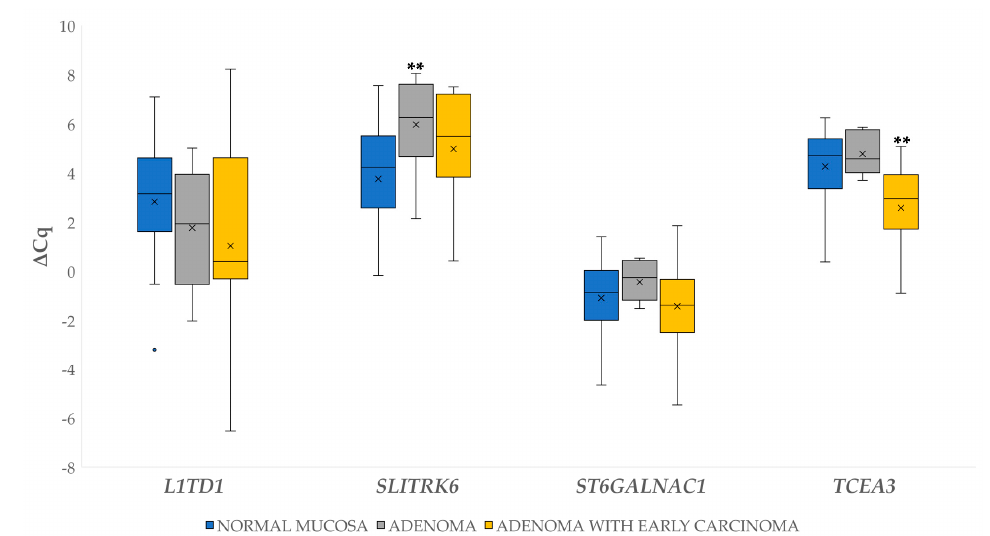
Figure 2. Expression ( ∆ Cq) of four genes ( L1TD1, SLITRK6, ST6GALNAC1, TCEA3) in normal mucosa, adenoma and adenoma with early carcinoma. Legend: x, mean; ◦ , outlier; * p ≤ 0.05; ** p ≤ 0.01.